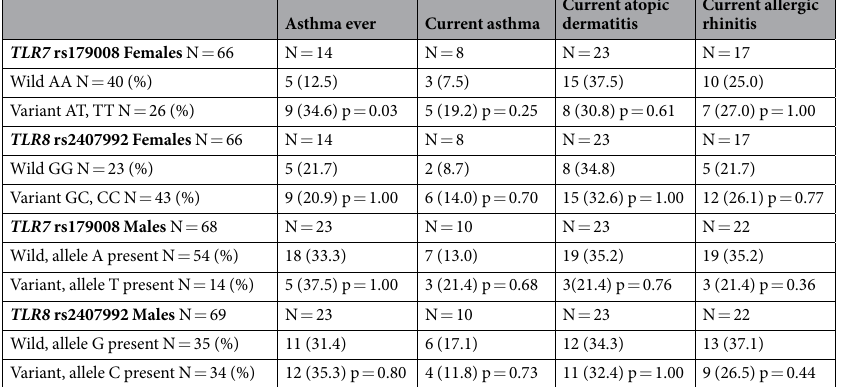
Table 3. Genotypes of TLR7 rs179008 and TLR8 rs2407992 encoding genes in relation to asthma and allergy at preschool age in 135 former bronchiolitis patients. TLR7 and TLR8 are presented separately for females and males. One test result of a TLR7 male presented AT heterozygote and was deleted from the